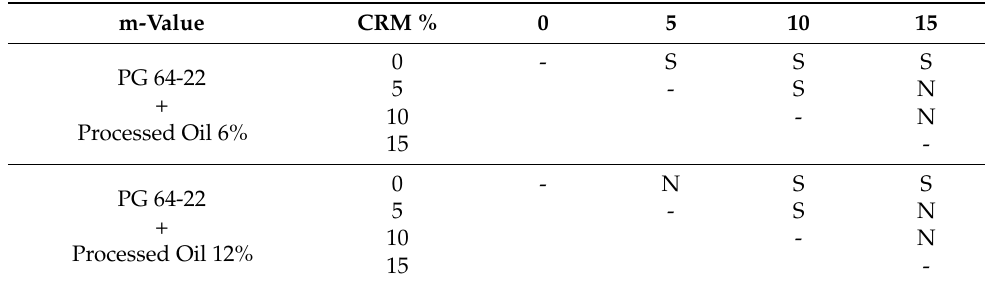
Table 12. Statistical analysis results of m-value for RTFO + PAV aged PG 64-22 with processed oil as a function of CRM content − 24 ◦ C ( α =